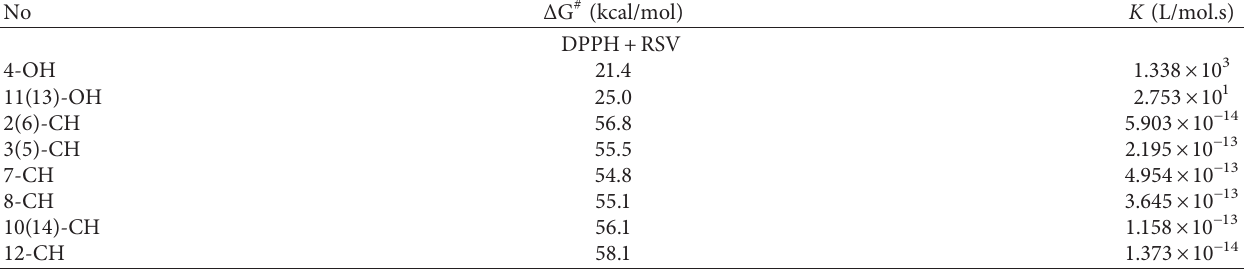
Table 4: DPPH radical attack on hydroxy and methine groups of RSV in water (calculated Δ G # and K at the B3LYP/6-311++G(d, p) level of